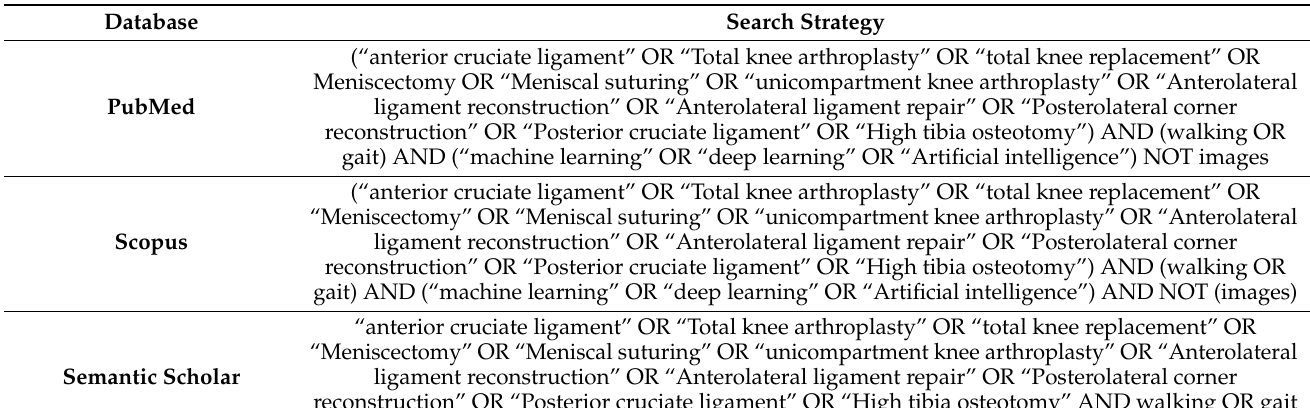
Table 2. Employed databases and search strategies.